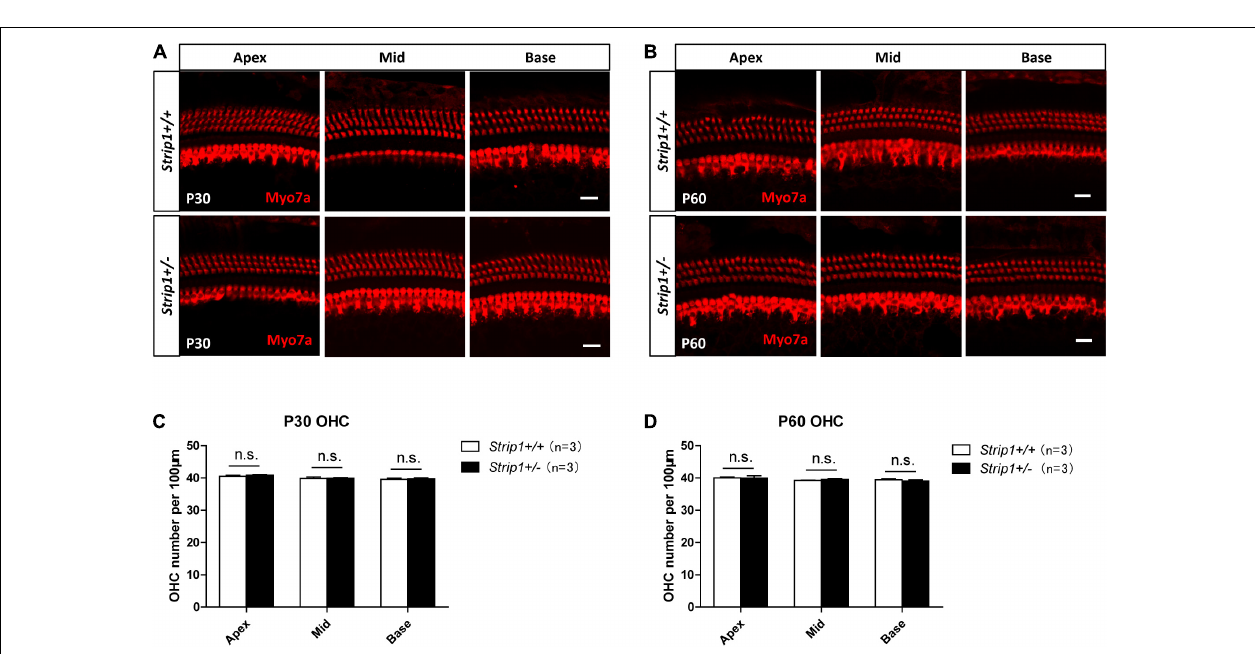
FIGURE 5 | The cochlear HCs in adult Strip + / − mice are normal. (A,B) Immunofluorescent staining of P30 (A) and P60 (B) cochleae from Strip + / − mice and Strip1 +/+ mice. Myo7a was used as the HC marker. Scale bar, 20 µ m. (C,D) Quantification of the OHC number per 100 µ m cochlear length in P30 (C) and P60 (D) Strip + / − mice and Strip1 +/+ mice. n refers to the number of mice. n.s., not significant.